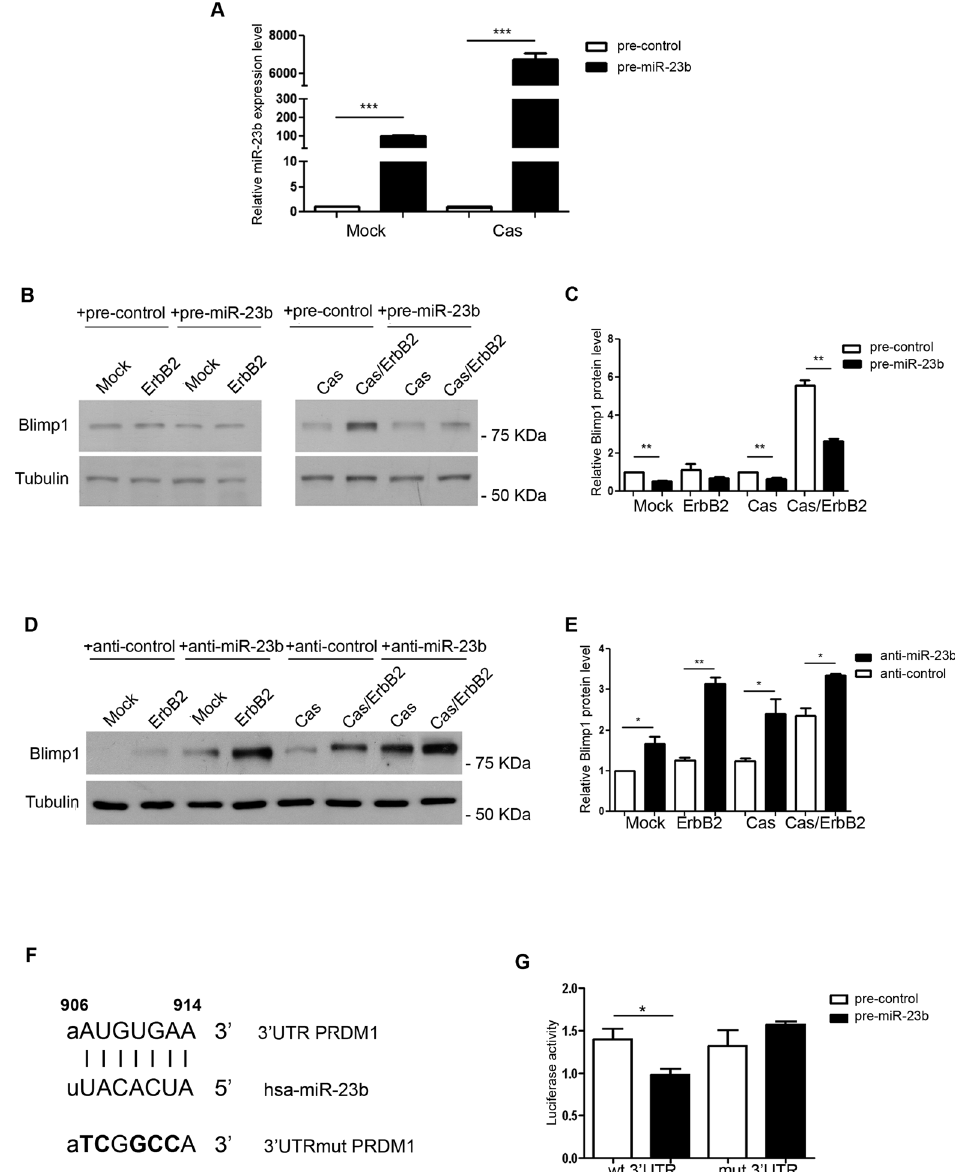
Figure 5. miR-23b directly binds to Blimp1 and regulates its expression. ( A ) miR-23b levels were evaluated using qRT-PCR in MCF10A.B2 Mock and Cas cells 48 hours after transfection with either the miR-23b precursor (pre-miR-23b) or negative controls (pre-control). Results were calculated as fold changes (mean ± s.e.m.) relative to controls, normalized to U44 ( *** p < 0.001). ( B ) Total cell extracts from Mock and Cas cells, that had been treated with 1 µ M AP1510 or left untreated, 48 hours after transfection with either the miR-23b precursor (pre-miR-23b) or negative controls (pre-control) were probed for Blimp1 in a western blot analysis. Tubulin was used as the loading control. Blimp1 protein modulation was calculated relative to Mock level and normalized to tubulin as the loading control. ( C ) Densitometric analysis of protein levels in at least three independent experiments is shown (mean ± s.e.m.). Statistical analysis was performed using the Student’s t-test ( ** p < 0.01). ( D ) Total cell extracts from Mock and Cas cells, that had either been treated with 1 µ M AP1510 or left untreated, 24 hours after transfection with either the miR-23b inhibitor (anti-miR-23b) or negative controls (anti-control) were probed for Blimp1 in a western blot analysis. Tubulin was used as the loading control. Blimp1 protein modulation was calculated relative to Mock level and normalized to tubulin as the loading control. ( E ) Densitometric analyses of protein levels in at least three independent experiments are shown (mean ± s.e.m.). Statistical analyses were performed using the Student’s t-test ( * p < 0.05, ** p < 0.01). ( F ) Seed matches and mutated binding sites (3 ′ UTRmut PRDM1) of miR-23b in the 3 ′ UTR of PRDM. Black bars indicate the seed matches, while bold letters indicate mutation sites. ( G ) Luciferase assays in HEK293 cells cotransfected with either wild-type or mutant PRDM1 3 ′ UTR reporter constructs, together with miR-23b precursors (pre-miR-23b) and negative controls